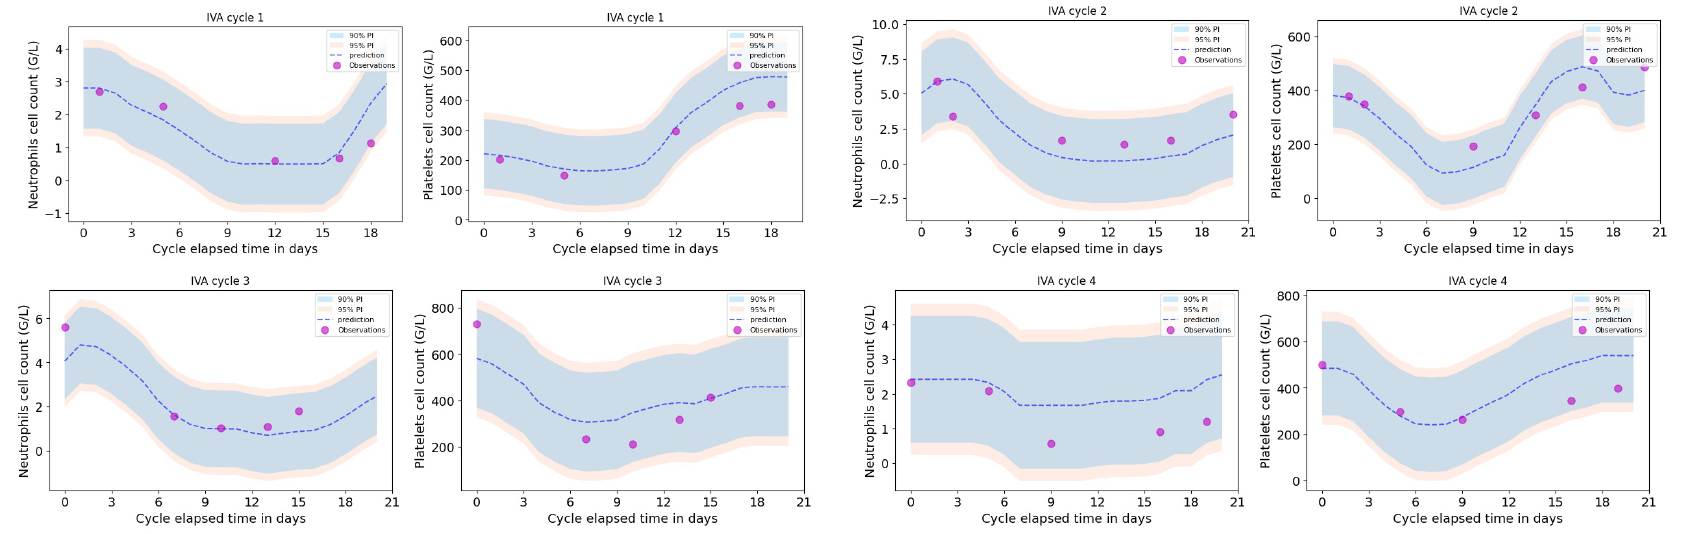
Figure 3. Examples of one patient’s validation results obtained for the neutrophils and platelets prediction models of the four first IVA treatment cycles. The magenta dots are the (true) observed neutrophils and platelets counts from the patient’s blood tests. The validation patient’s data were removed from the dataset on which the regression models were trained and optimized. The dashed line shows the neutrophils and platelets predictions from the trained models with input parameters that corresponded to the validation patient’s neutrophils and platelets initial counts and the ifosfamide initial dose. The shaded areas, which illustrate the 90% and 95% prediction intervals, are proportional to the cycle-based model’s standard deviation computed from the entire leave-one-out cross validation